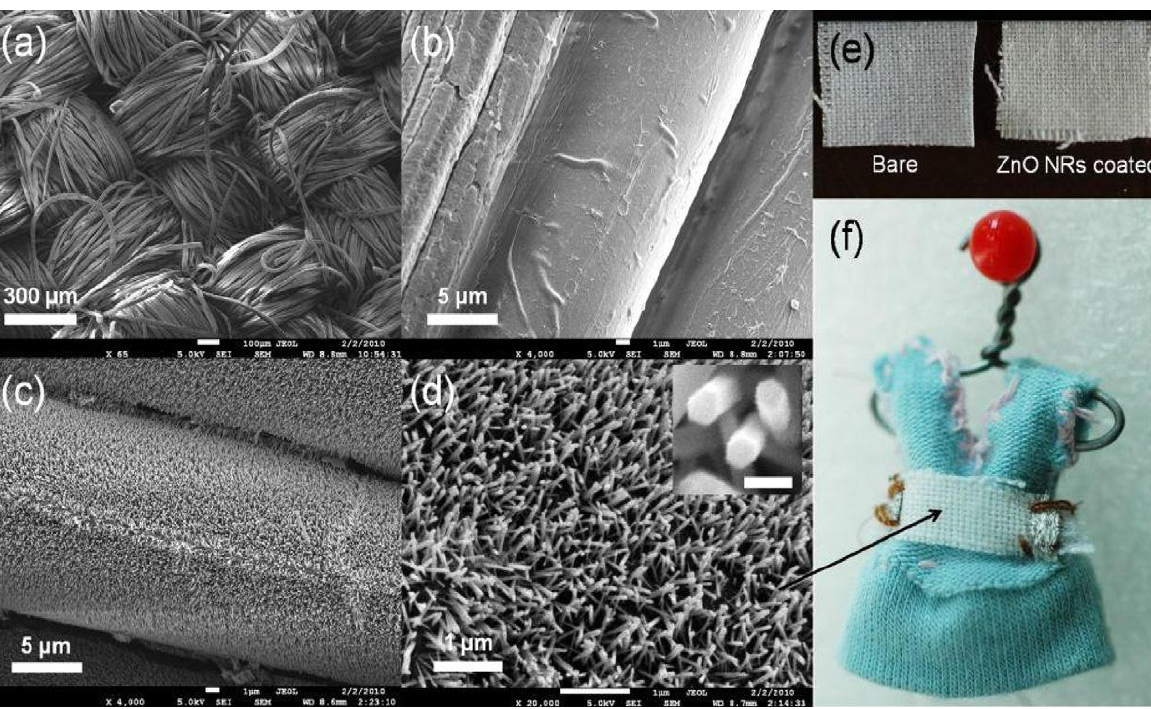
Figure 2. SEMimages of ( a ) cotton fabric substrate in low magnification; ( b ) bare cotton fibres; ( c ) ZnO NR-coated cotton fibres and ( d ) high magnification images of ZnO NRs on a cotton fibre. Scale bar in the inset represents 100 nm; ( e ) Photograph bare and ZnO